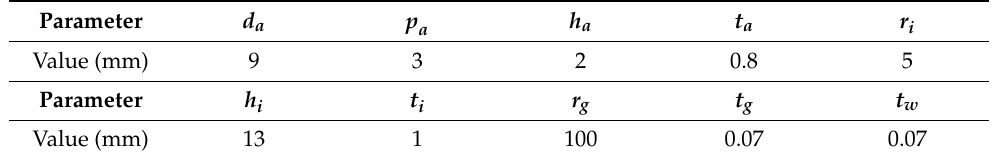
Figure 8. Measurement system for evaluating the radiation efficiency of a submerged antenna. Table 1. Fabricated Antenna Parameter.